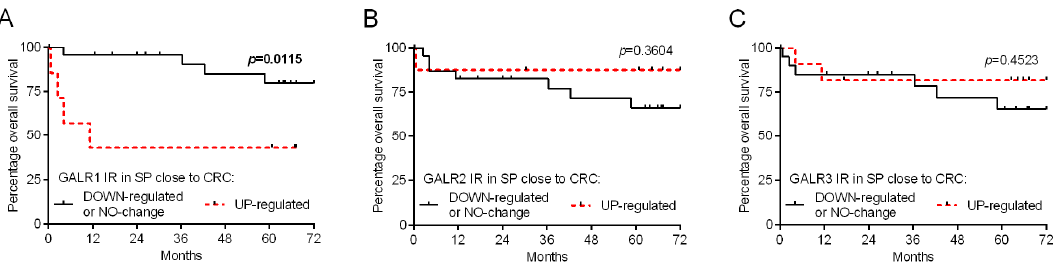
Figure 8. Kaplan–Meier diagrams that show the relative immunoexpression of galanin receptors (GALR1—( A ), GALR2—( B ), and GALR3—( C )) in submucosal plexuses (SP) regarding the overall survival of colorectal cancer (CRC) patients (n = 32). Table 3. Analysis of overall survival of CRC patients in relation to GALRs immunoexpression in